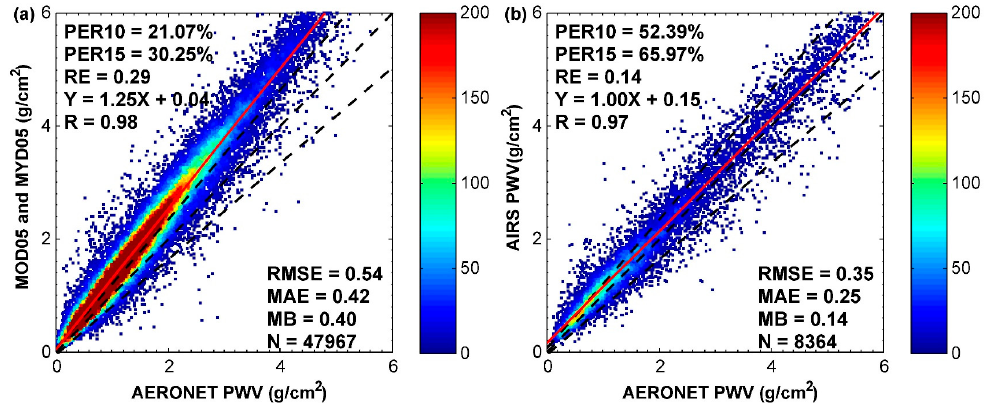
Figure 8. Scatter plot of matching results between the AERONET PWV data, MODIS PWV dataset and AIRS PWV dataset in 2020. ( a ) MODIS PWV dataset, ( b ) AIRS PWV dataset.